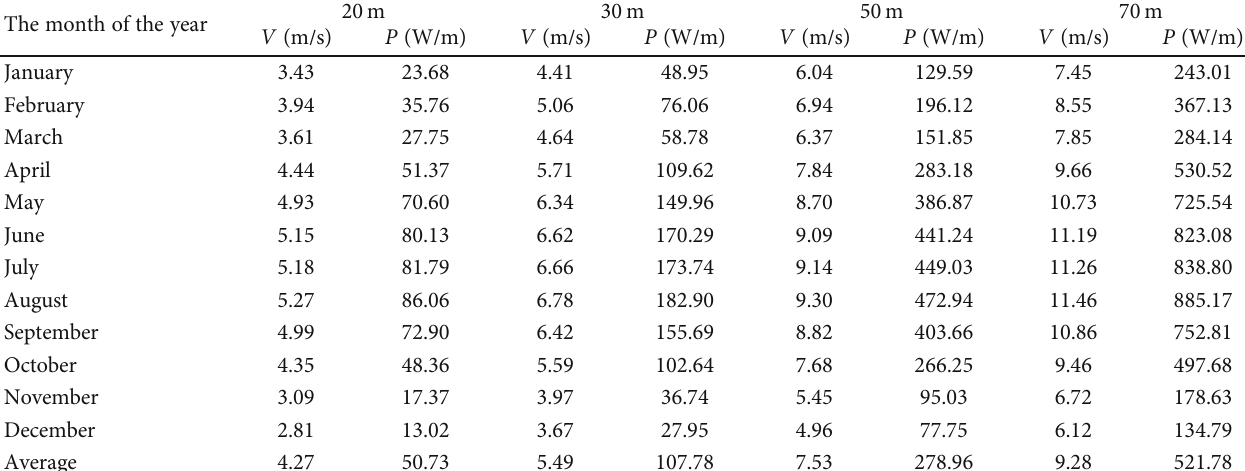
Table 5: Extrapolated wind power for Kisii subject to Betz limit.